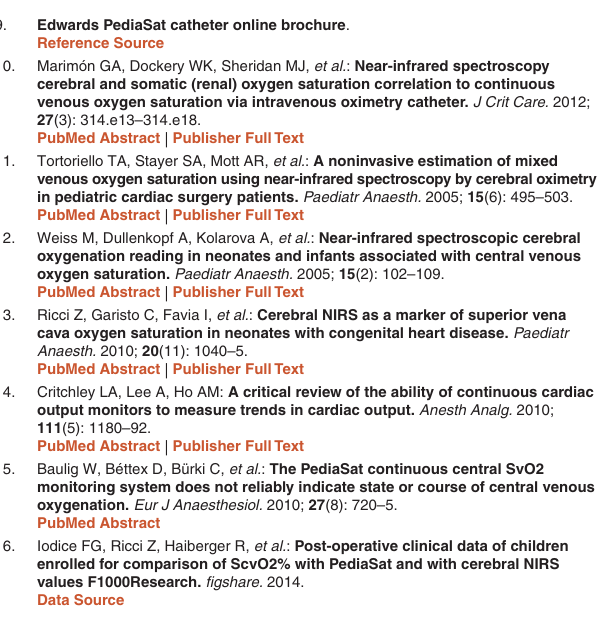
figshare : Post-operative clinical data of children enrolled for com- parison of ScvO2% with PediaSat and with cerebral NIRS values. doi: http://dx.doi.org/10.6084/m9.figshare.900915